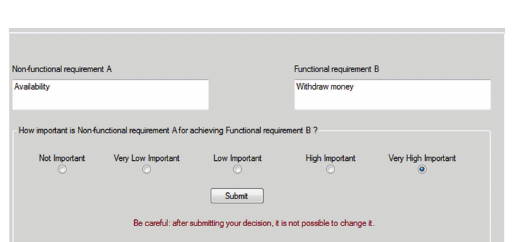
Figure 3: A snapshot of the graphical user interface showing a pair ofrequirements(availabilityandwithdrawmoney)underevaluation in